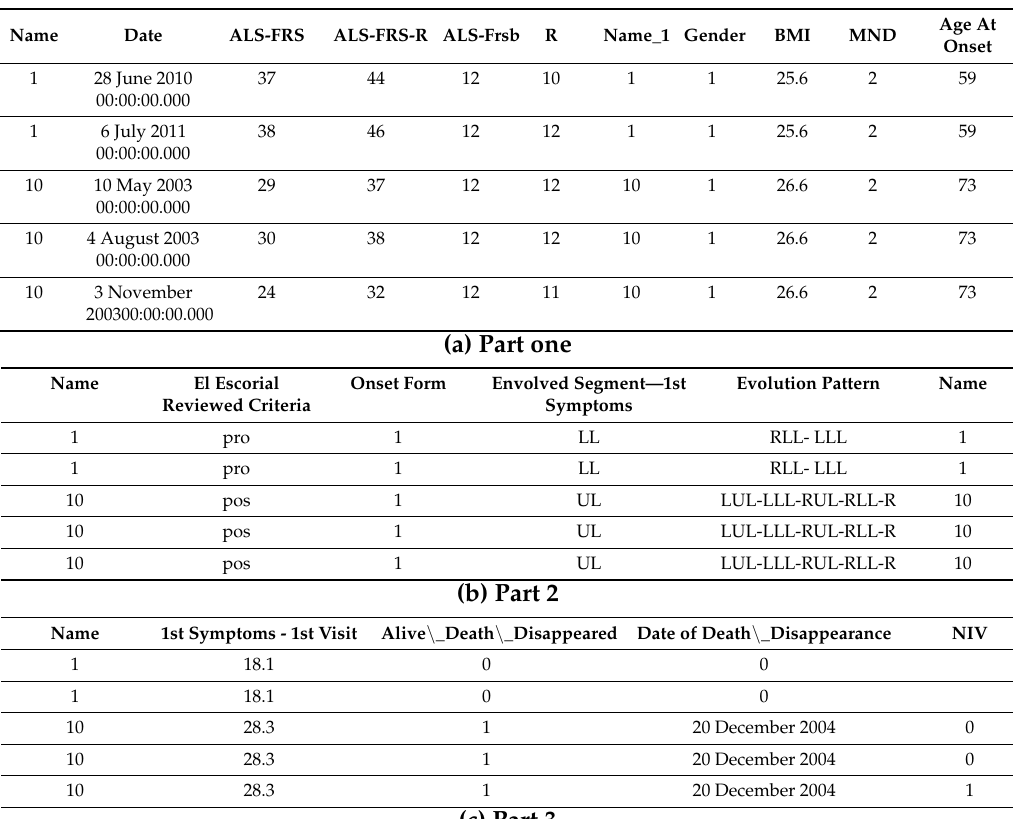
Table 11. Demographics output table generated using demographics original input information. The table is partitioned in three parts due to its